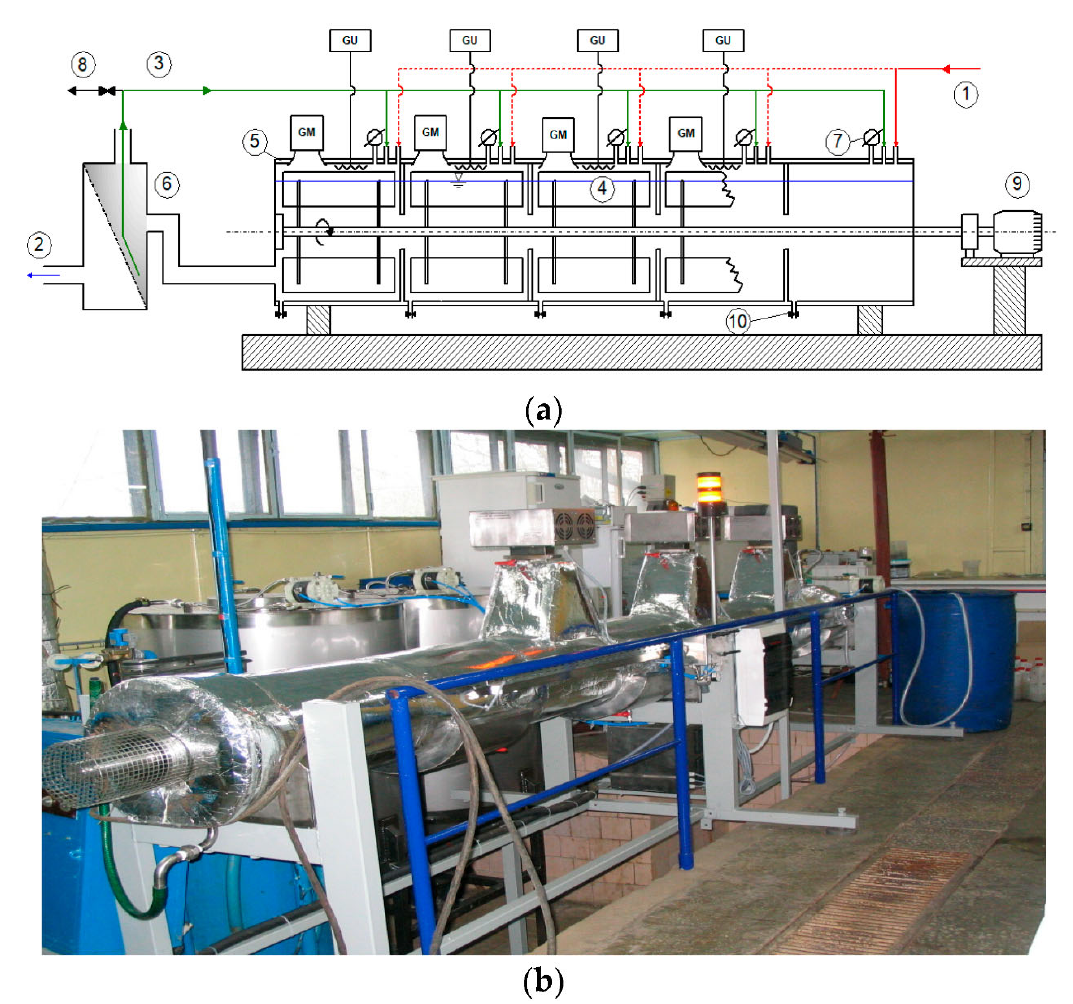
Figure 12. Horizontal flow anaerobic reactor (HFAR) ( a ) schematic diagram, ( b ) photo. 1—influ ‐ ent, 2—effluent, 3—sludge recirculation, 4—mixing blade, 5—thermal insulation, 6—membrane